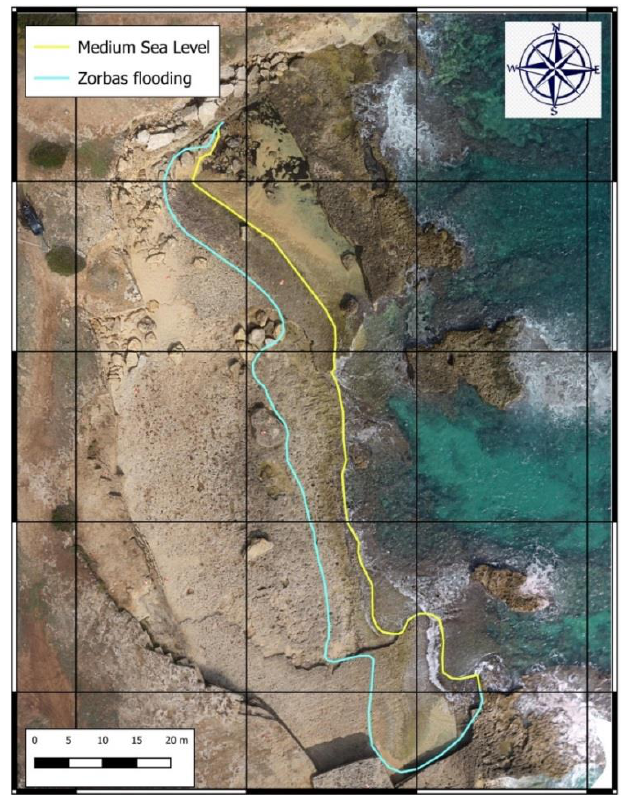
Figure 14. Flooding generated by Zorbas on the coastal area of the quarry evaluated through the video frames in condition of minimum turbulences.